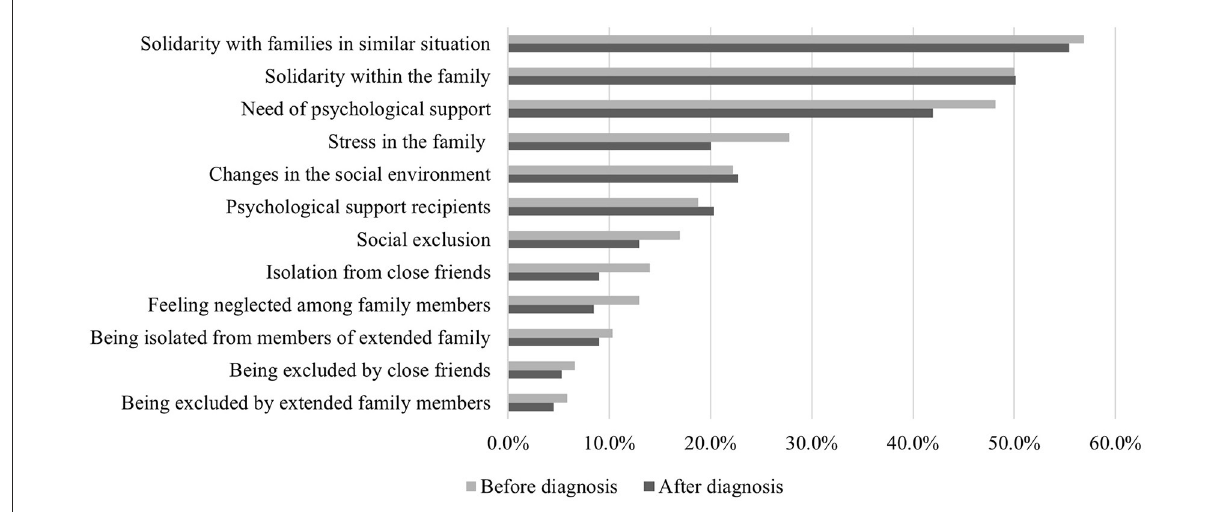
FIGURE2 The changes in experiences before and after diagnosis. The experiences of the patients before and after the diagnosis were evaluated in two questions and the results were compared. A total of 378 participants answered the question and more than one option could be